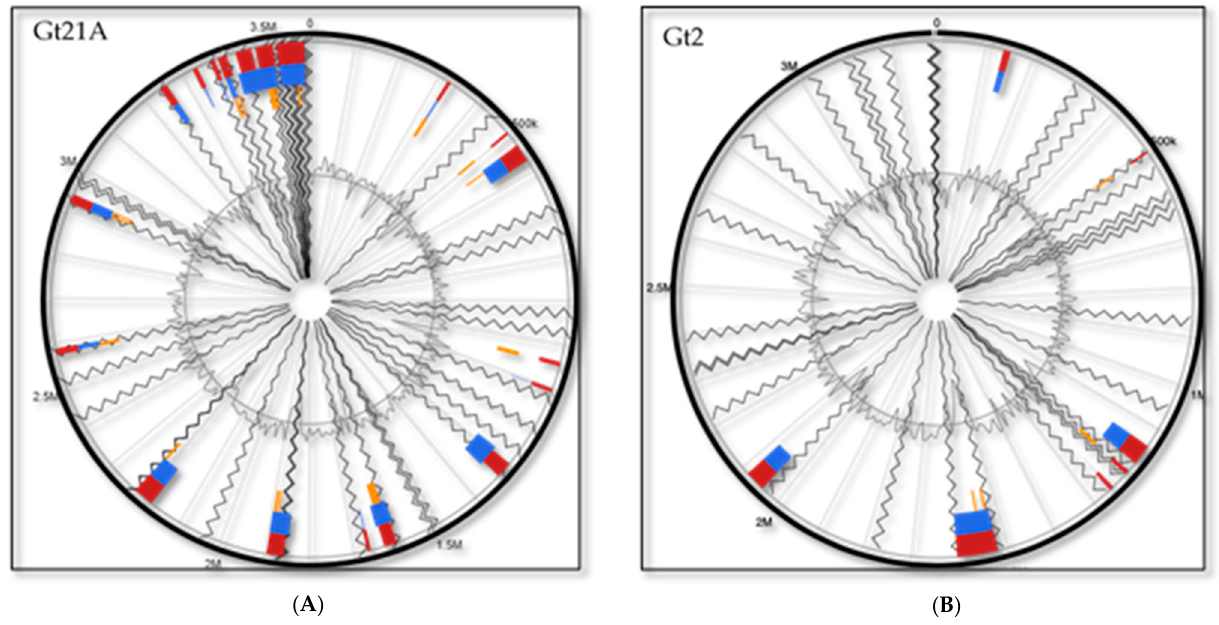
Figure 3. Circular plots visualizing genome islands predicted in the ( A ) UTNGt21A and ( B ) UTNGt2 genomes, aligned against the complete reference genome L. plantarum WCFS1, with blocks colored according to the prediction method. IslandPath-DIMOB (blue), SIGI-HMM (orange), and the integrated results (dark red).